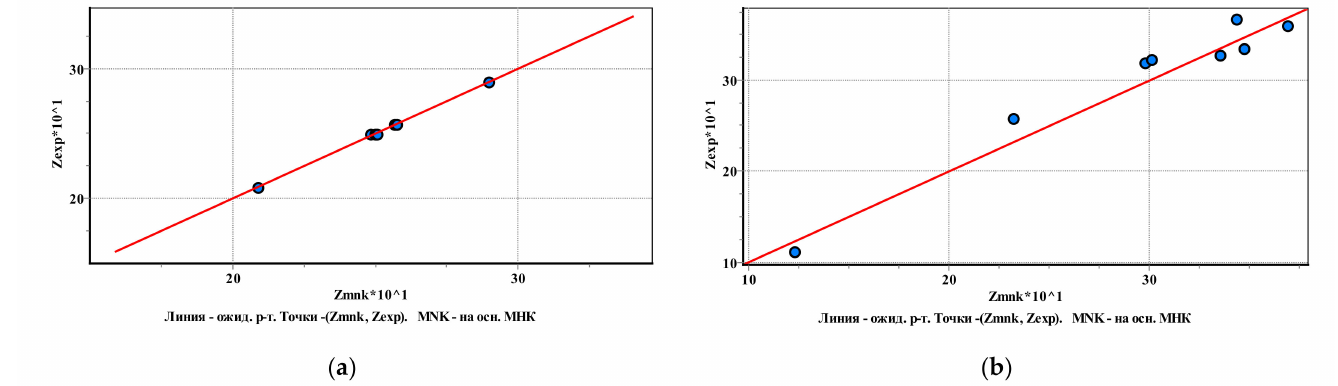
Figure 8. The correspondence of the results of laboratory and theoretical values of strength character- istics: ( a )—angle of internal friction; ( b